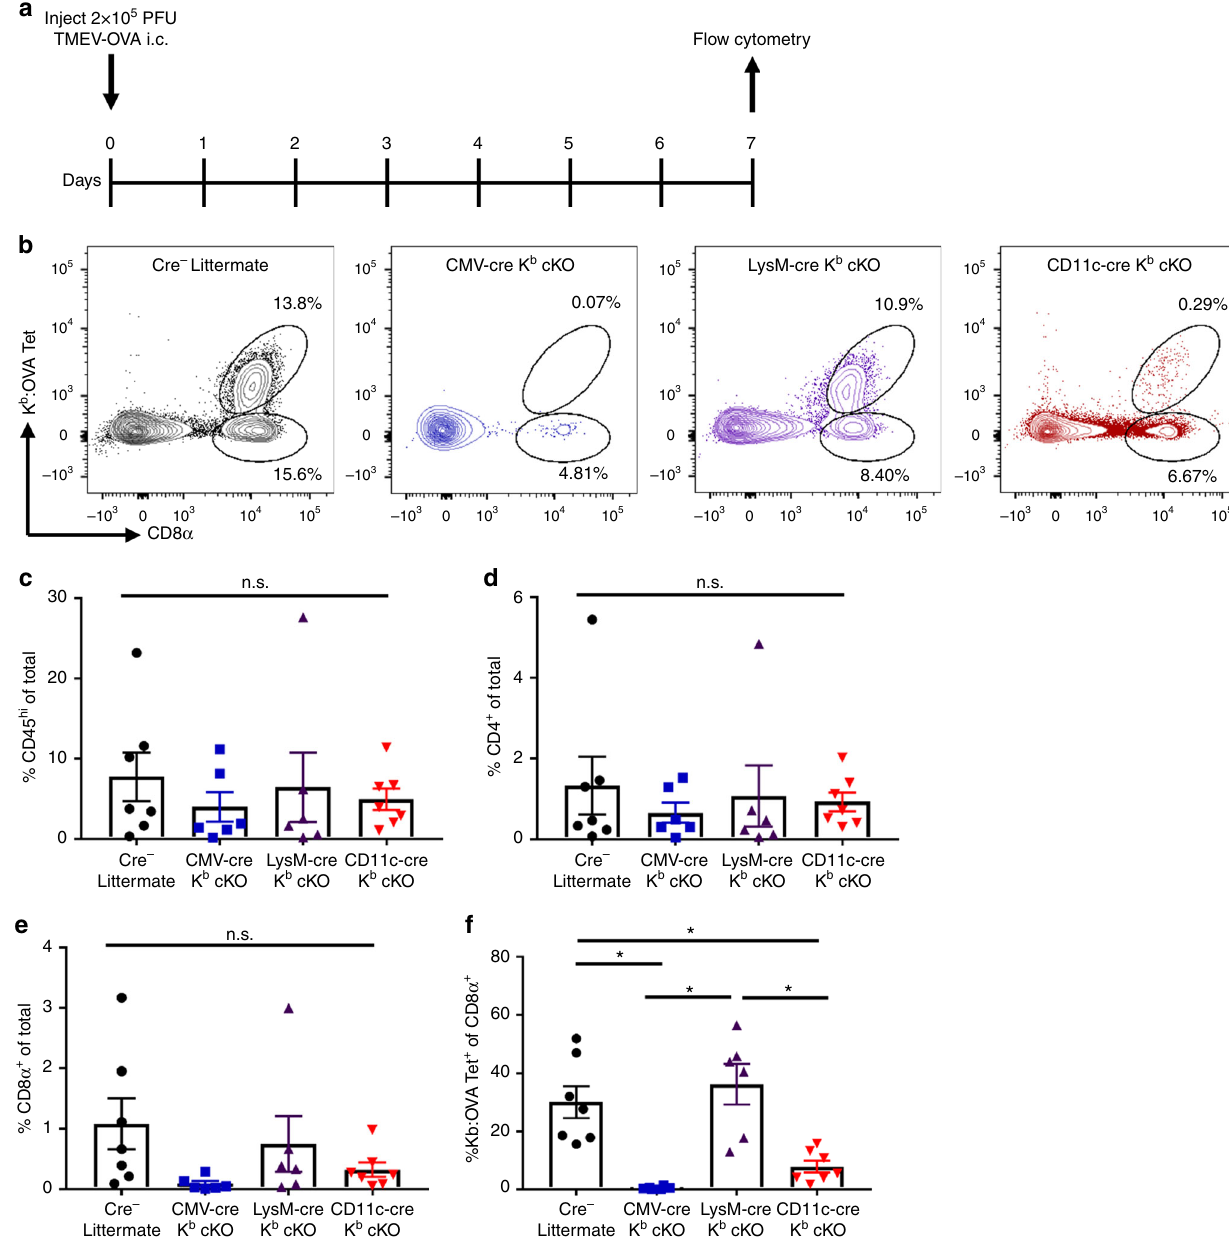
Fig. 6 Dendritic cell-speci fi c deletion of K b ablates CD8 + T-cell response to picornavirus infection. a Animals were challenged with 2 × 10 5 plaque forming units (PFU) TMEV-OVA. Brains were isolated for fl ow cytometry 7 days post infection. b Representative fl ow plots. c Quanti fi cation of CD45 hi ( c ) CD4 + T cells ( d ) or total CD8 + T cells ( e ) demonstrate no difference in immune cell in fi ltration into the CNS. f Quanti fi cation demonstrates that CD11c-cre K b cKO animals are unable to generate CD8 + T-cell responses following acute CNS infection with TMEV-OVA ( N = 7, 6, 6, 7 per group, respectively). d Quanti fi cation of OVA-speci fi c CD8 + T-cell responses were tracked using K b :OVA MHC I tetramer. Data presented as mean with error bars representing standard error of the mean (SEM). * denotes p < 0.05 by Mann − Whitney U Test or one-way ANOVA with Holm − Sidak